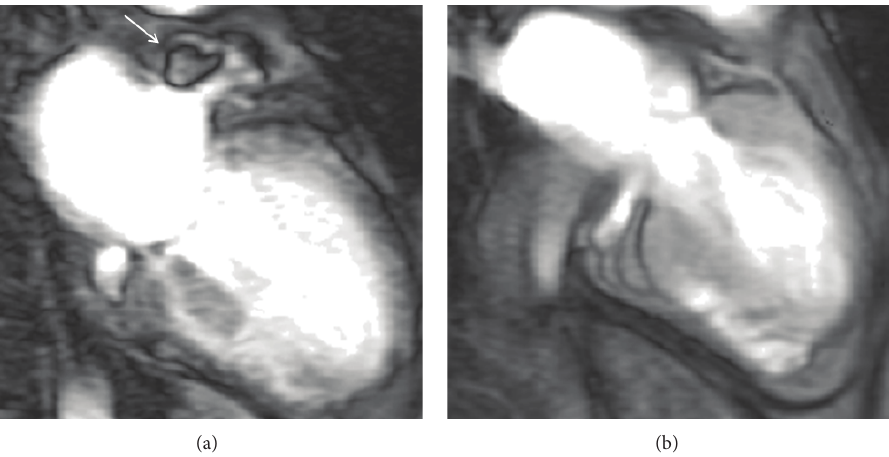
Figure 1: Cardiovascular magnetic resonance (CMR) image of a patient with AF in the early phase following gadolinium administration. On the left image demonstrates thrombus (white arrow) in the LAA and on the right 6 months later, following anticoagulation therapy with warfarin and confirming resolution of the